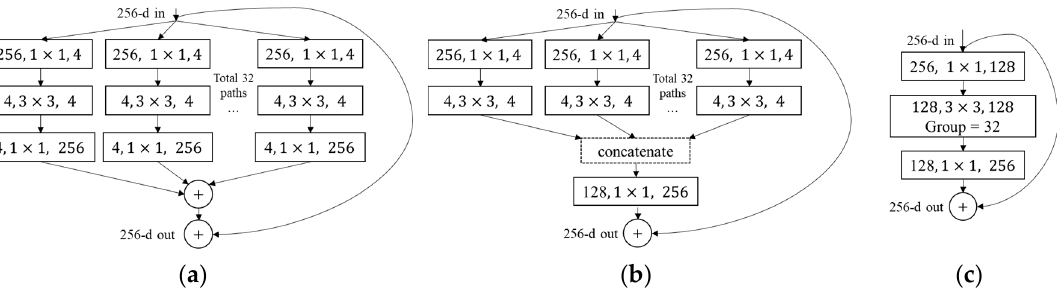
Figure 7. ResNeXt structure [41]. In the figure above, the structure of ( a ) is the original structure of ResNeXt, and ( b , c ) are equivalent representations of the structure of ( a ) in an actual implementation, the structure of ( c ) which is relatively simple to implement, and the basic block of ResNeXt is realized through the form of grouped convolution.